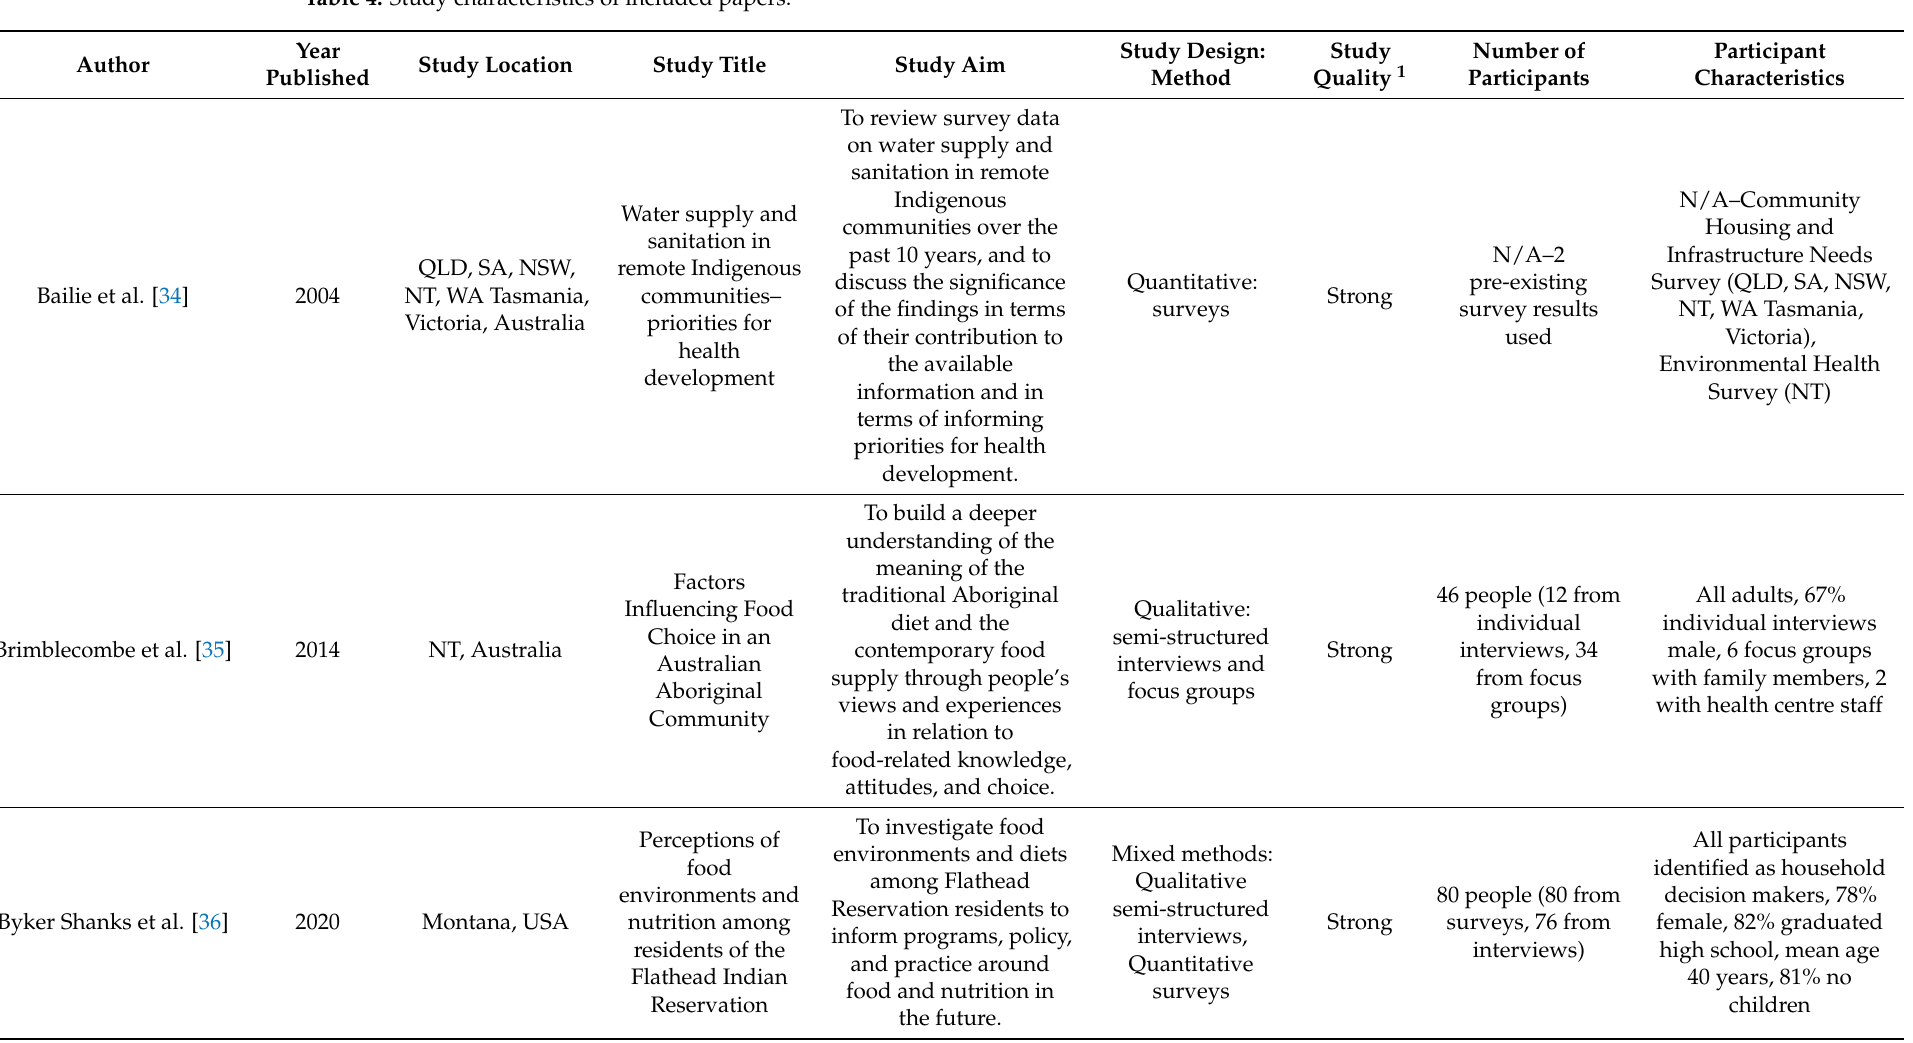
Table 4. Study characteristics of included